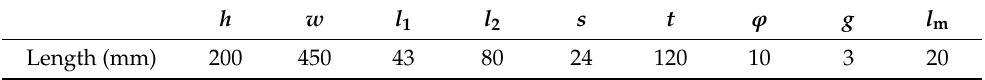
Table 1. Parameters of the position and size dimension of the coil, magnet, spring, and plate. h w